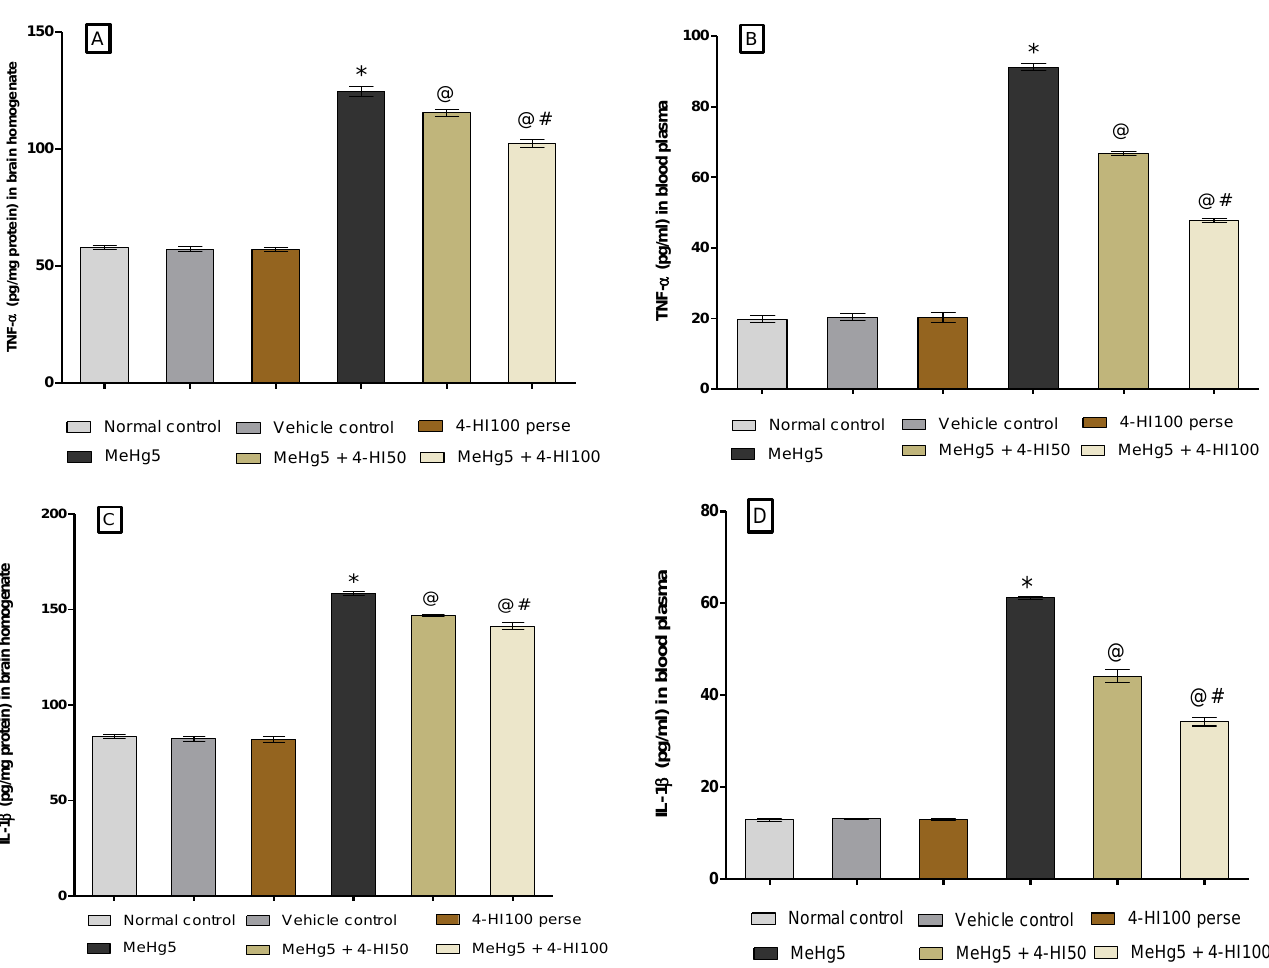
Figure 13. Effect of 4-hydroxyisoleucine on neuroinflammatory cytokines after methyl mercuryex- posure in rats ( A – D ). Statistical analysis by one-way ANOVA (posthoc Tukey’s test). Values are expressed as mean ± SEM ( n =6 rats per group). * p <0.001 v/s normal control, vehicle control and 4-